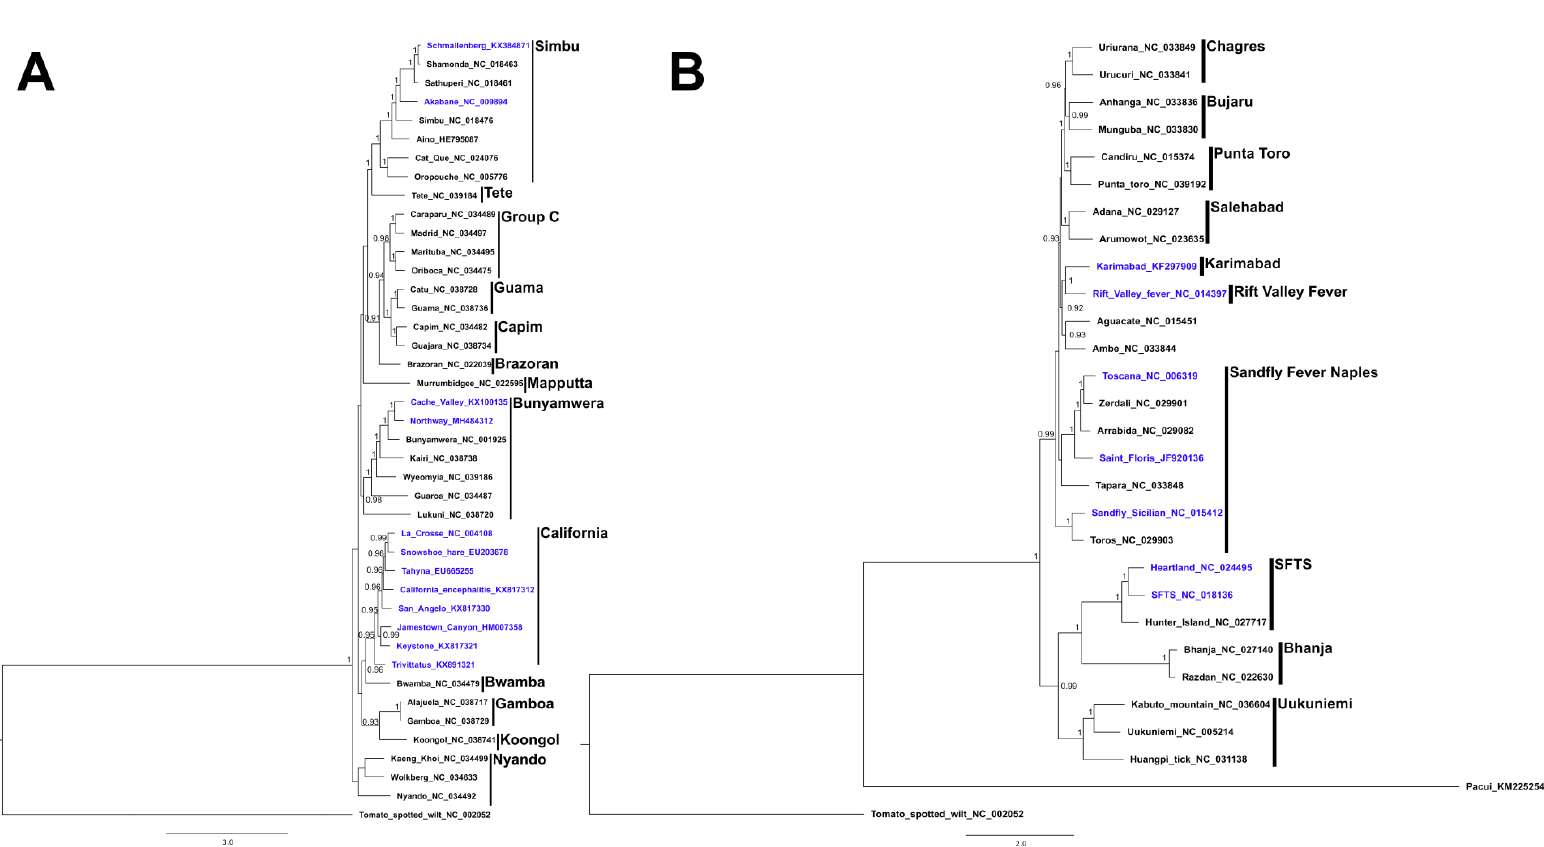
Figure 1. Bayesian phylogenetic trees based on nucleotide sequence of the RDRP for ( A ) orthobunyaviruses and ( B ) phleboviruses. In addition to viruses discussed in the paper available on GenBank, Orthobunyavirus, and Phlebovirus sequences available via RefSeq were included in the alignment. Nucleotide sequences were aligned by translating to amino acid, aligning using MUSCLE [116], and back translating to nucleotide. Columns in the alignment were removed where gaps contributed to 80% of the column composition using Trimal [117]. Substitution models were chosen with jModelTest2 (GTR Γ + I for both phylogenies) [118]. Trees were generated in Mr. Bayes [119] with 5,000,000 steps, sampling every 1000 and discarding the first 10% as burn-in. Convergence was assessed by examining the stationary ln-likelihood and effective sample size (ESS, >200) parameters in Tracer v1.7.1 (BEAST, Auckland, New Zeland). Posterior probabilities reported on the trees are >0.9.